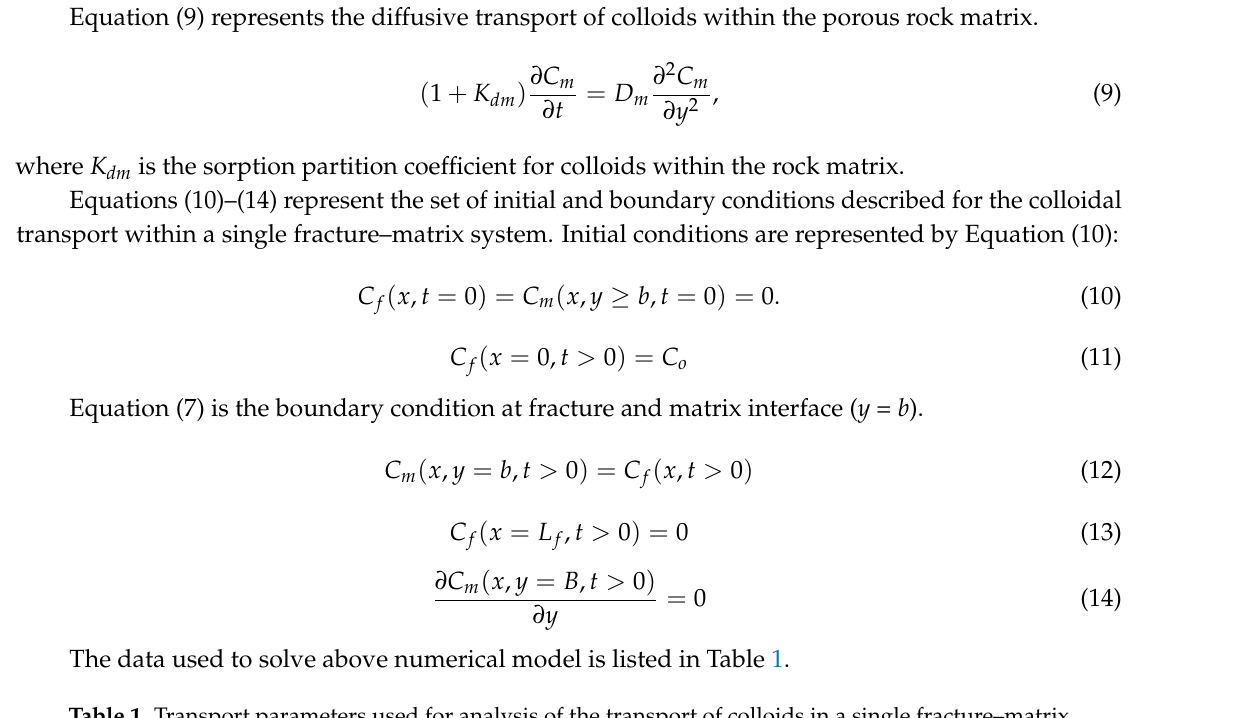
Table 1. Transport parameters used for analysis of the transport of colloids in a single fracture–matrix system with variable fracture